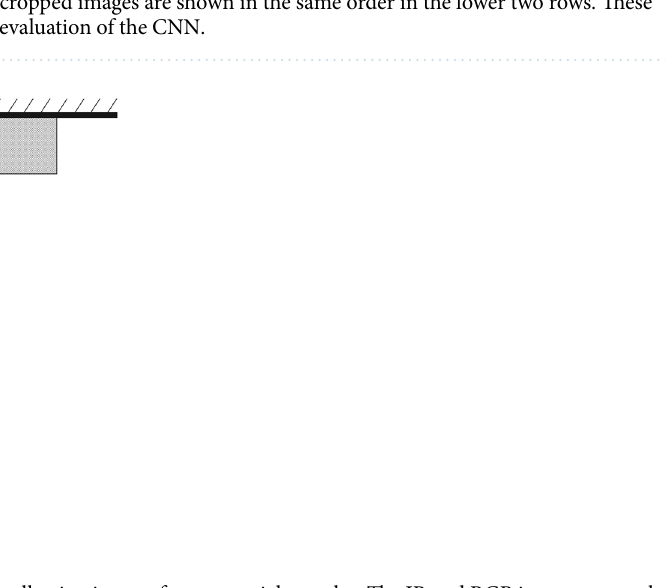
Figure 2. Experimental design of collecting images from material samples: The IR and RGB images were taken with an angle α < 90 ◦ and a distance d between 1 and 2.5